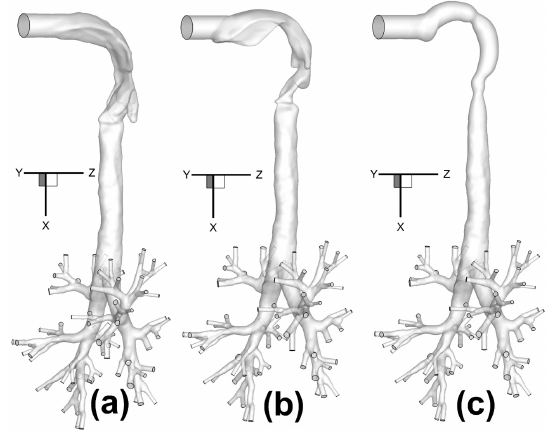
Figure 1. Configurations of human respiratory systems consisting of three human upper airway geometries with the same tracheobronchial tree: ( a ) Geometry A; ( b ) Geometry B; ( c ) Geometry C.